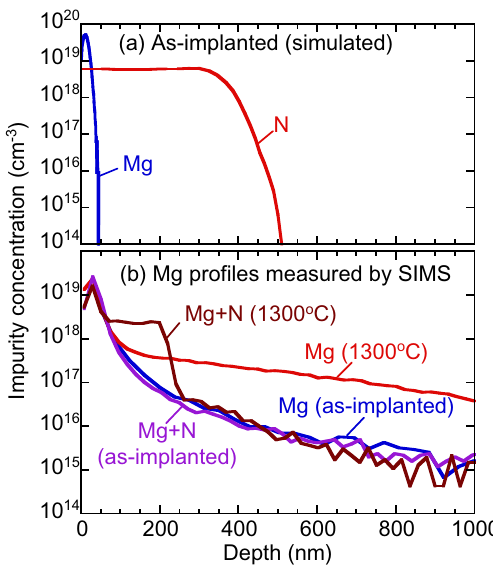
Figure 1. ( a ) Computer simulated depth distributions of Mg and N for as-implanted GaN. ( b ) Depth distributions of Mg for Mg-implanted GaN with and without N-implantation (denoted as “Mg + N” and “Mg”) measured by SIMS. Annealing temperature is shown in figure.